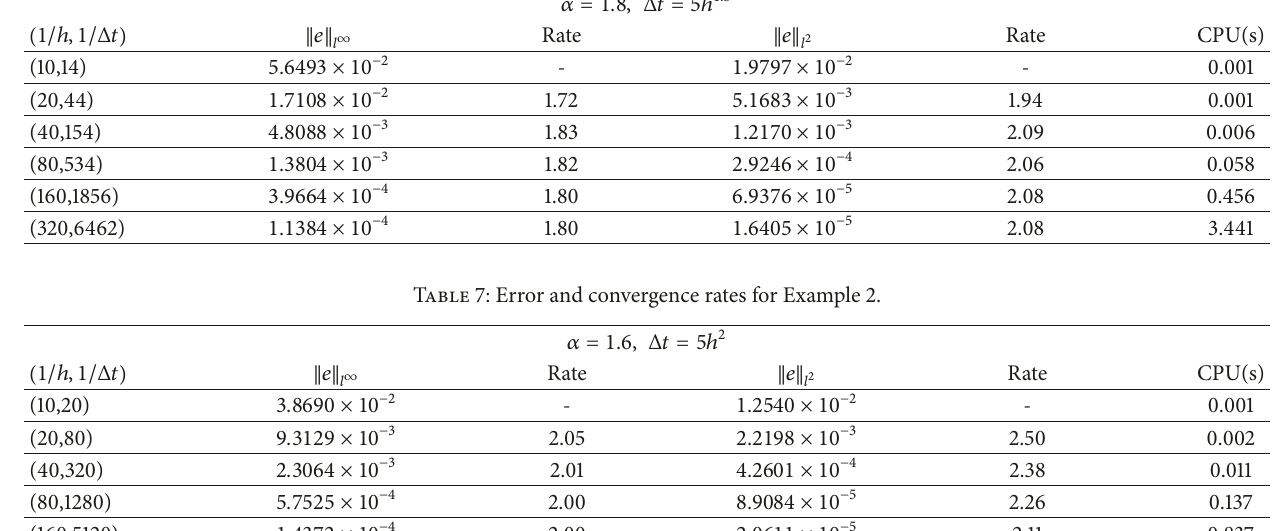
Table 6: Error and convergence rates for Example 2. 𝛼 = 1.8, Δ𝑡 = 5ℎ 1.8